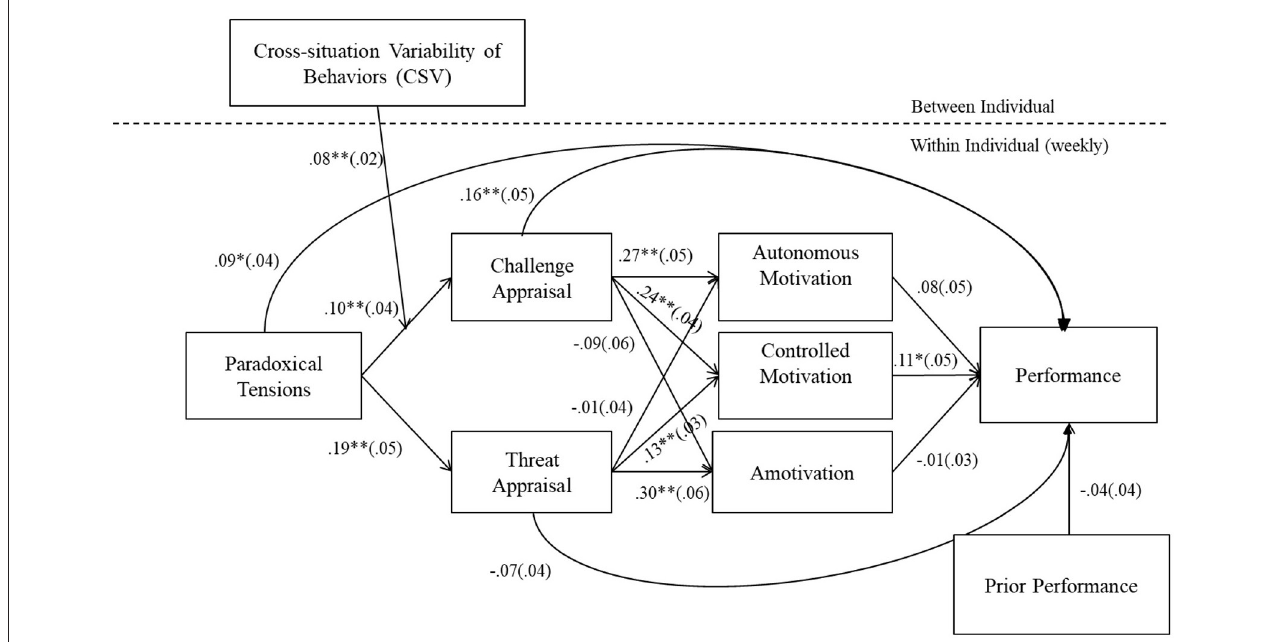
FIGURE 1 | Effect of paradoxical tensions on weekly performance. N = 178, Number of observations = 1,355; Sample size is smaller for lagged and cross-level analysis; Unstandardized regression coefficients are reported. Between-person effects are controlled. * p < 0.05, ** p < 0.01, Two-tailed